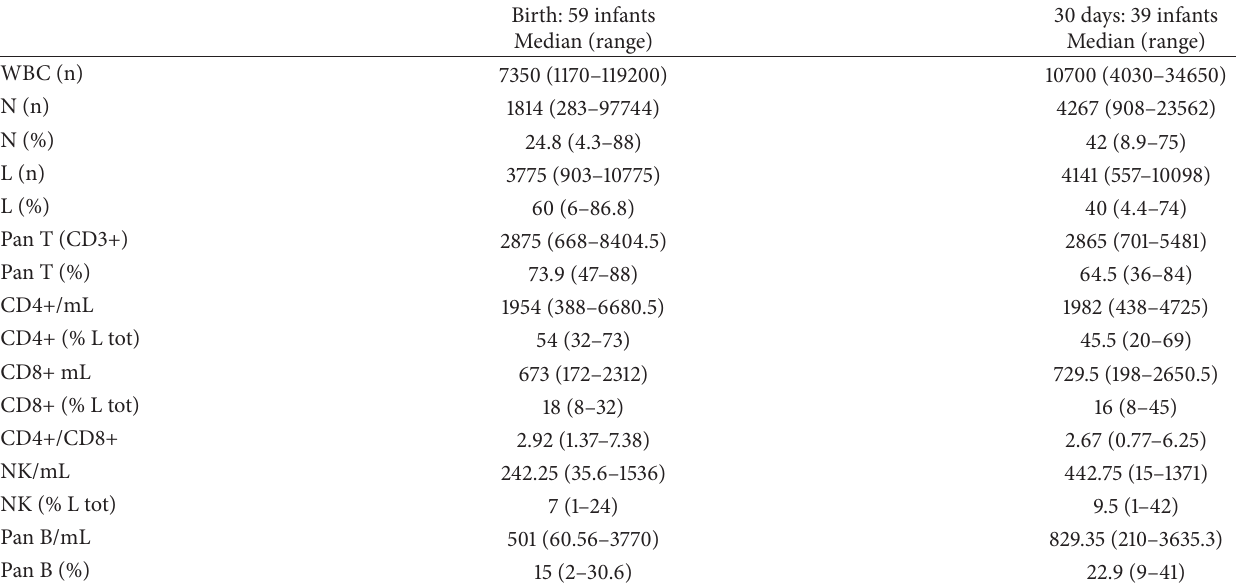
Table 1: Lymphocytes subpopulations at birth and at 30 days of age of infants enrolled in the study (WBC: white blood cells, N: neutrophils, L: lymphocytes, and NK: natural killer lymphocytes).